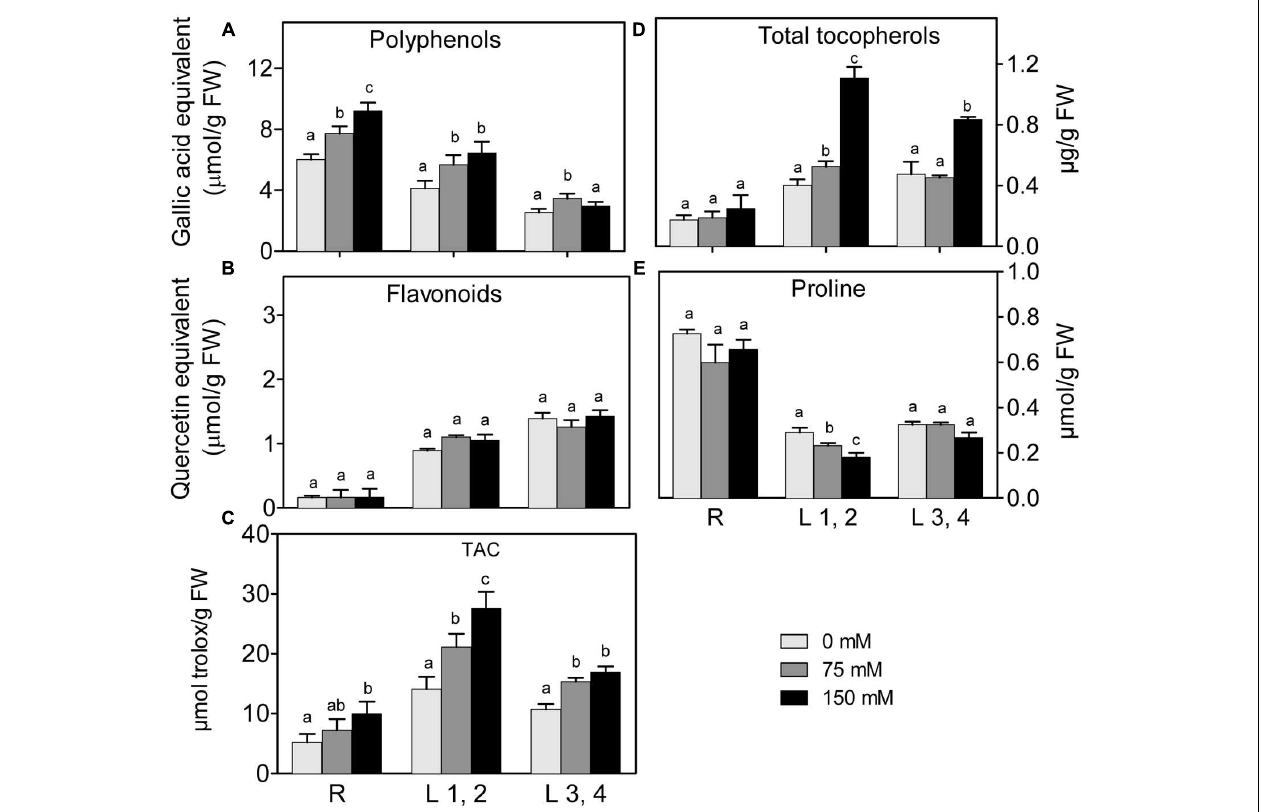
FIGURE 4 | Effect of different salinity levels on polyphenols (A), flavonoids (B), total antioxidant capacity (TAC, C), total tocopherols (D), and Proline (E) content of root (R), mature leaf pair (L1,2) and young leaf pair (L3,4) of 3 weeks old maize seedlings. Values are means of at least three replicates and significant differences between means, as determined by Duncan test ( P < 0.05), are indicated by different